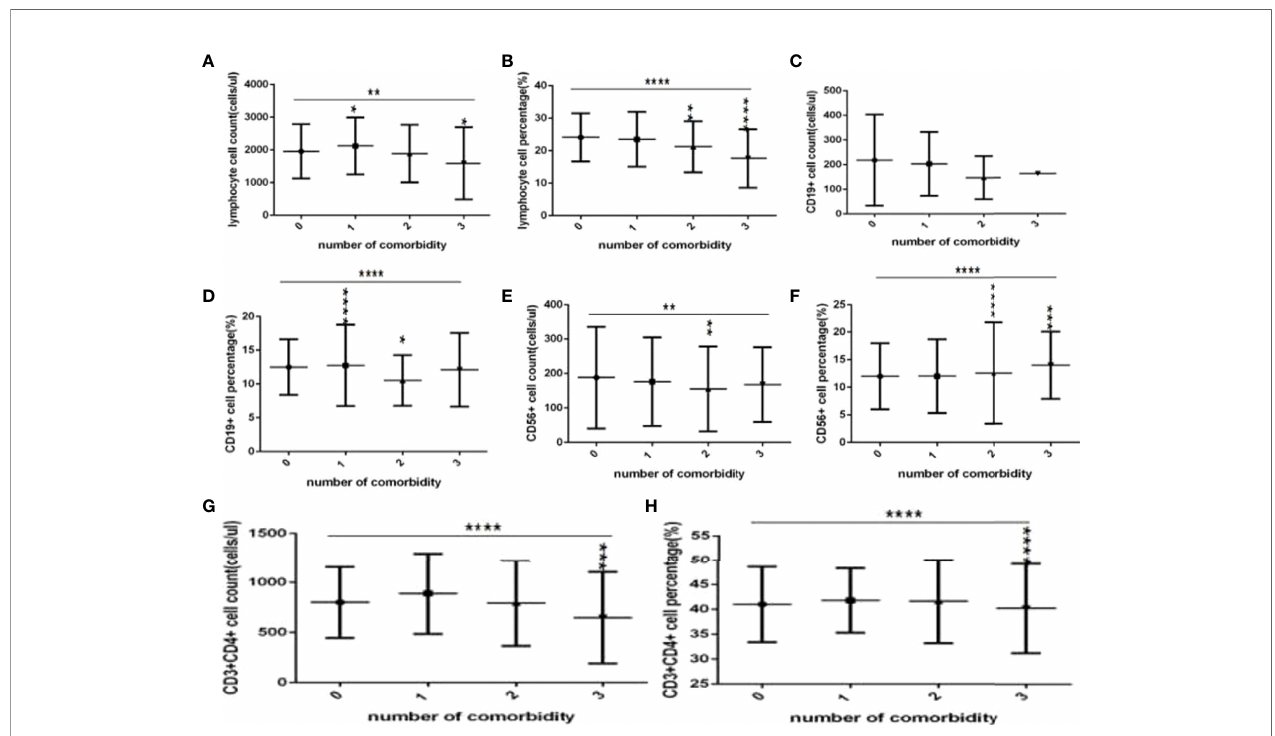
FIGURE 6 | Comparison of lymphocyte, T, B and NK cell subset counts and percentages among the different numbers of comorbidities ( n =718; 0, 1, 2, 3 or more comorbidity groups, n =253, 193, 127 and 145 cases, respectively). C0OVID-19, coronavirus disease 2019. NAFLD, nonalcoholic fatty liver disease. DM, diabetes mellitus. CHB, chronic hepatitis (B) COPD, chronic obstructive pulmonary disease. CKD, chronic kidney disease. CVD, cardiovascular disease. (A) lymphocyte count. (B) lymphocyte percentage. (C) CD19+ count. (D) CD19+ percentage. (E) CD56+ count. (F) CD56+ percentage. (G) CD3+ count. (H) CD3+ percentage. Unpaired one-way ANOVA was used for intergroup comparisons ( B, D, F, G, H P all < 0.0001; A, C , P all <0.01; E , P >0.05). Unpaired t -tests were used for comparisons with the no comorbidity group, * P < 0.05, ** P < 0.01, *** P < 0.001, **** P <